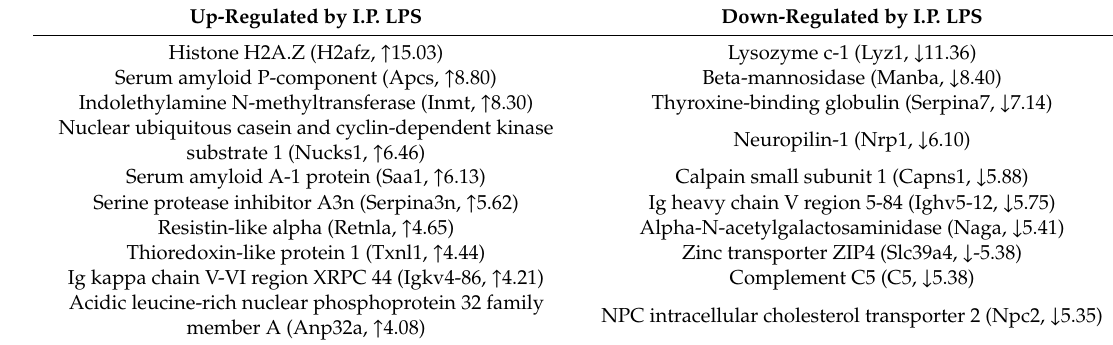
Table 4. Top 10 up- or down-regulated BALF proteins by I.P. LPS compared to the controls. Up-Regulated by I.P. LPS Down-Regulated by I.P. LPS Histone H2A.Z (H2afz, ↑ 15.03) Lysozyme c-1 (Lyz1, ↓ 11.36) Serum amyloid P-component (Apcs, ↑ 8.80) Beta-mannosidase (Manba, ↓ 8.40) Thyroxine-binding globulin (Serpina7, ↓